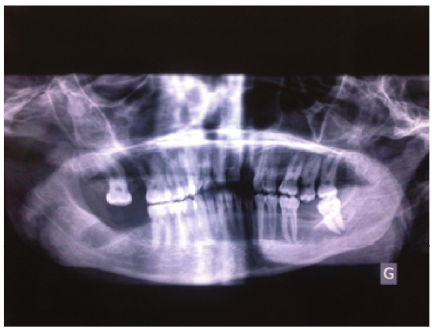
Figure 1: Preoperative panoramic radiograph.